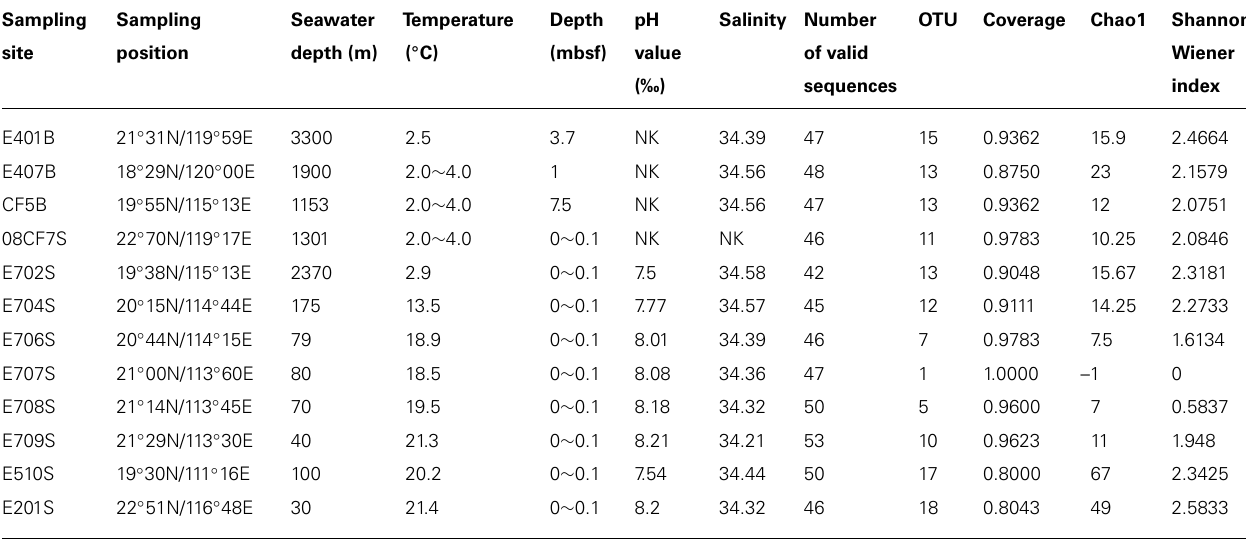
Table 1 | Physiochemical parameters and location information together with mcrA gene diversity and richness indices of sediments collected from South China Sea.